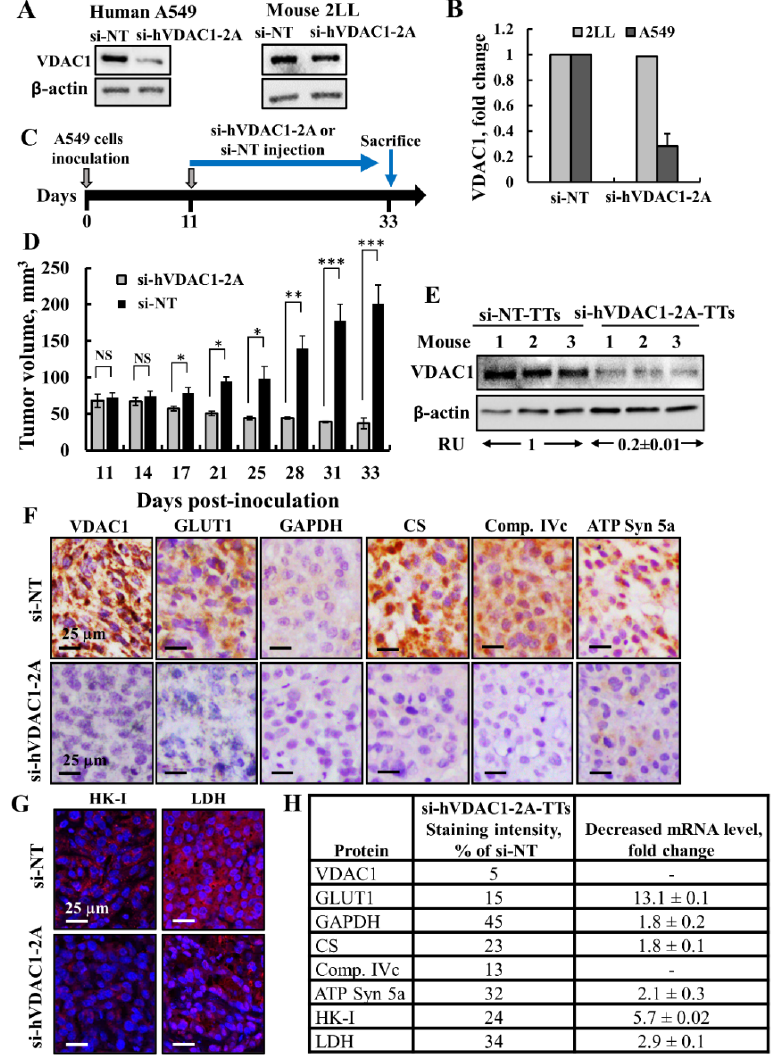
Figure 1. Human ‐ specific siRNA si ‐ hVDAC1 ‐ 2A specifically silences human but not mouse VDAC1, inhibits lung cancer cell ‐ derived xenograft growth, and reduces the expression of metabolism ‐ related proteins. ( A ) A549 and 2LL cell lines were transfected with si ‐ NT or si ‐ hVDAC1 ‐ 2A and analyzed for VDAC1 expression using anti ‐ VDAC1 antibodies. Cells were transfected using jetPRIME reagent and 100 nM of siRNA (Figure S1F,G,I for uncropped Western Blot). ( B ) Quanti ‐ tative analysis of VDAC1 protein levels in the si ‐ hVDAC1 ‐ 2A ‐ treated cells, relative to si ‐ NT ‐ treated cells, is presented as relative units (RUs). ( C ) Schematic presentation of the course of the experiment and siRNA treatment initiation. ( D ) A549 cells (3 × 10 6 ) were subcutaneously (s.c.) inoculated into nude mice. When tumor size reached 70 mm 3 , the mice were divided into two matched groups, and xenografts were injected intratumorally every 3 days with si ‐ NT (black bars, 7 mice) or si ‐ hVDAC1 ‐ 2A (gray bars, 8 mice) to a final concentration of 100 nM. The calculated average tumor volumes are presented as means ± SEM (* p ≤ 0.05, ** p ≤ 0.01, *** p ≤ 0.001), NS—non ‐ specific. ( E ) si ‐ NT ‐ TT and si ‐ hVDAC1 ‐ 2A ‐ TT sections from A549 xenograft mice were analyzed for VDAC1 levels by immunoblotting (Figure S1H for uncropped West ‐ ern Blot). Relative units (RUs) presented as the mean ± SEM; n = 3 mice. ( F , G ) Representative IHC staining using specific antibodies against VDAC1, GLUT1, GAPDH, citrate synthase (CS), complex IVc (Comp.IVc), and ATP synthase 5a (ATP Syn 5a) ( F ) or IF staining for HK ‐ I and LDH ( G ) of si ‐ NT ‐ TT and si ‐ hVDAC1 ‐ 2A ‐ TT sections derived from A549 xenografts. ( H ) Quantitative analysis of the levels of metabolism associated proteins IHC stained section intensity using Image J soft ‐ ware, presented as the percentage of the si ‐ hVDAC1 ‐ 2A ‐ TT staining intensity, relative to that in si ‐ NT ‐ TTs, and their levels as analyzed by qRT ‐ PCR analysis of mRNA and presented as fold change.